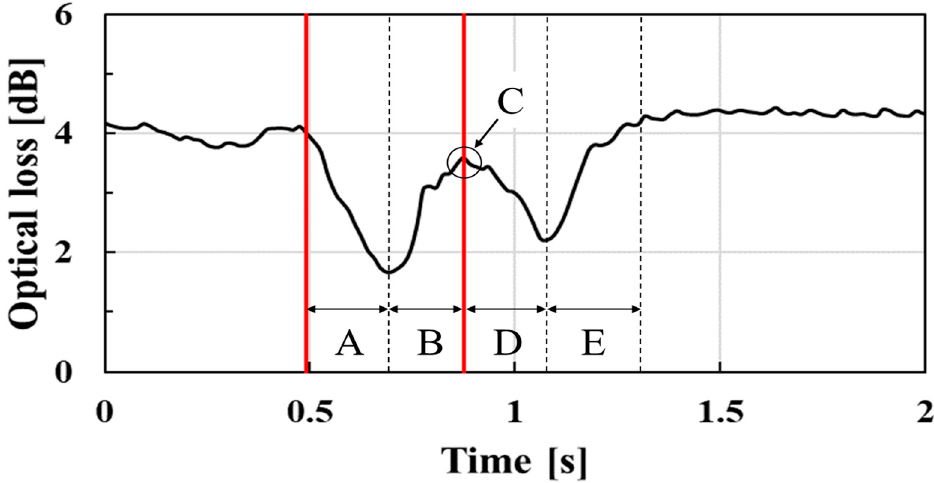
Figure 9. Response by laryngeal movement during